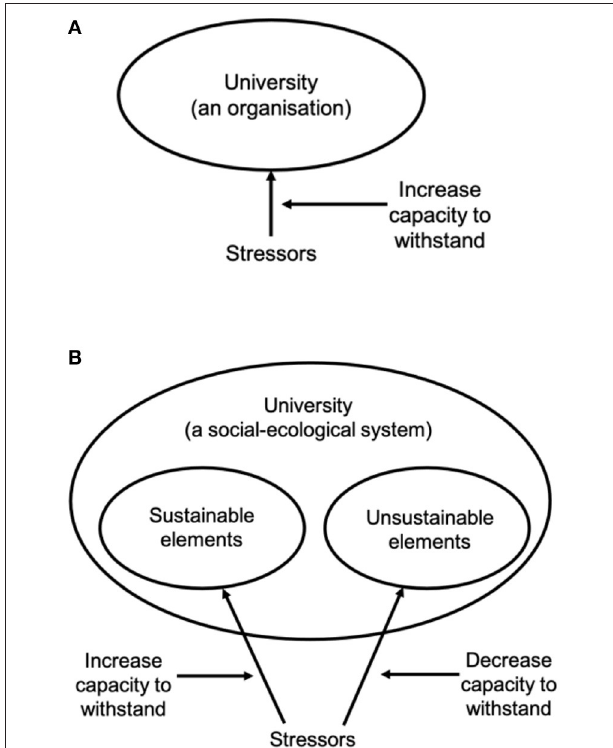
FIGURE 1 | (A) How resilience is typically conceptualised for an organisational context. Resilience is considered to be a desirable state and therefore the focus is on increasing the organisations’ capacity to withstand stressors. (B) How resilience is conceptualised in this paper. Resilience is considered to be a non-normative construct and therefore its desirability is dependent on the subject in question. In this study, we take the stance that there should be an increased capacity of the sustainable elements within the university to withstand stressors, and a decreased capacity of unsustainable elements to withstand